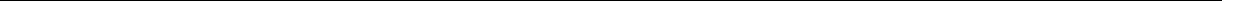
Fig. 2 Selectively reduced intra-epithelial lymphocytes in Trpm7 R/R mice. a Dot plot (left) and statistical analyses (right) of intra-epithelial lymphocytes (IEL) from WT or Trpm7 R/R mice stained as indicated. Percentages are shown in each gate, bar charts show mean percentages ± s.e.m. (WT, n = 6; Trpm7 R/R , n = 7). b Dot plot (left) and statistical analyses (right) of lamina propria lymphocytes (LPL) from WT or Trpm7 R/R mice stained as indicated. Percentages are shown in each gate, bar charts show mean percentages ± s.e.m. ( n = 7). c Absolute numbers (WT, n = 6; Trpm7 R/R , n = 7) of the indicated IELs subsets. Bar charts show mean percentages ± s.e.m. d Absolute numbers (mean ± s.e.m. n = 7) of the indicated LPL subsets. e CD3 immunohistochemical staining of small intestine sections of WT or Trpm7 R/R mice and relative quanti fi cation (right). Scale bars indicate 100 µ m. f Dot blots and statistical analyses of MHCII expression in EpCAM + intestinal epithelial cells (IEC). Percentages are shown in each gate, bar charts show mean percentages ± s.e.m. ( n = 3). g Quantitative real-time PCR of T-bet , Foxp3 , Rorc and Il-17a expression in puri fi ed TCR αβ + CD4 + IELs from WT or Trpm7 R/R mice. h Dot plot and statistical analyses of IFN- γ and IL-17A staining in WT or Trpm7 R/R TCR αβ + CD4 + IELs. Percentages are shown in each gate, bar charts show mean percentages ± s.e.m. (WT, n = 5; Trpm7 R/R , n = 8). Data are representative results of at least 3 independent experiments. A two-tailed Student ’ s t test was used with * p < 0.05; ** p < 0.01 and *** p <